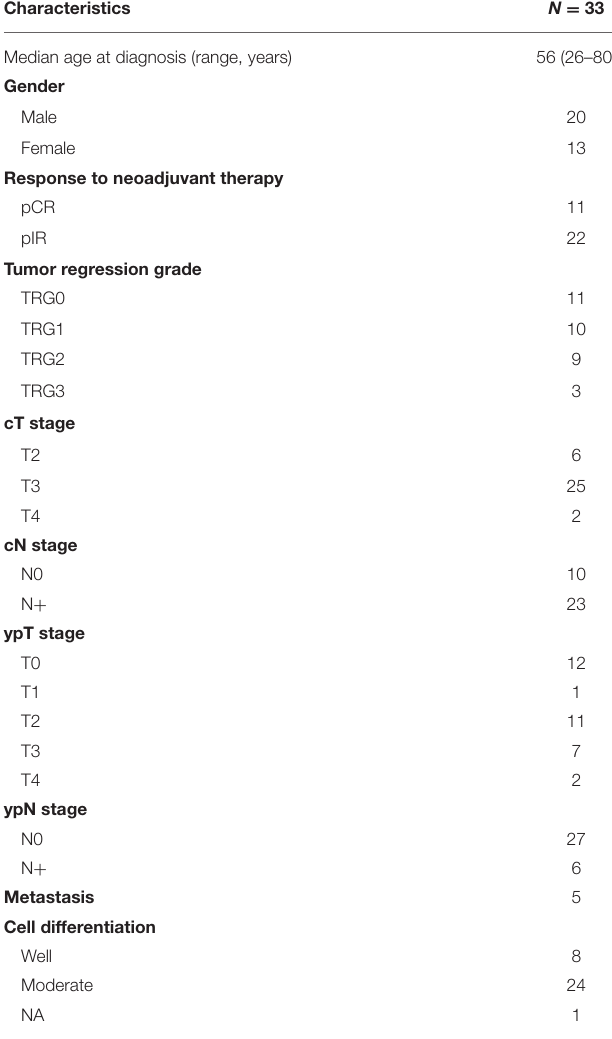
TABLE 1 | Clinical and histopathological characteristics of 33 locally advanced rectal cancer patients included in this study.